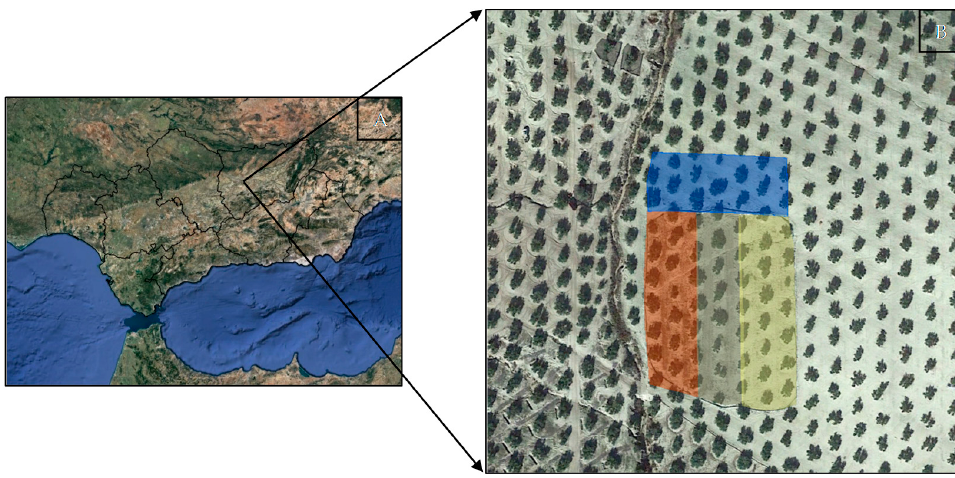
Figure 1. Location map Andalusia region ( A ) and aerial view of the experimental treatments ( B ); conventional tillage (blue); saffron (orange); oats (grey), and lavender (yellow